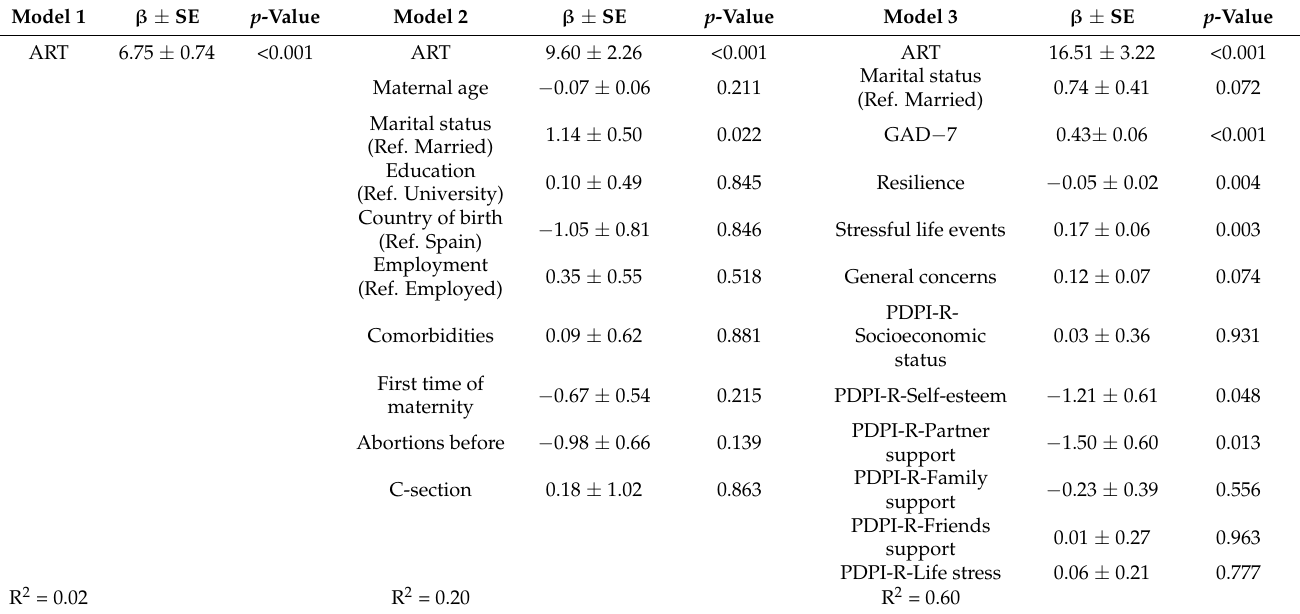
Table 4. Generalized regression models associated with PHQ-9 scale.